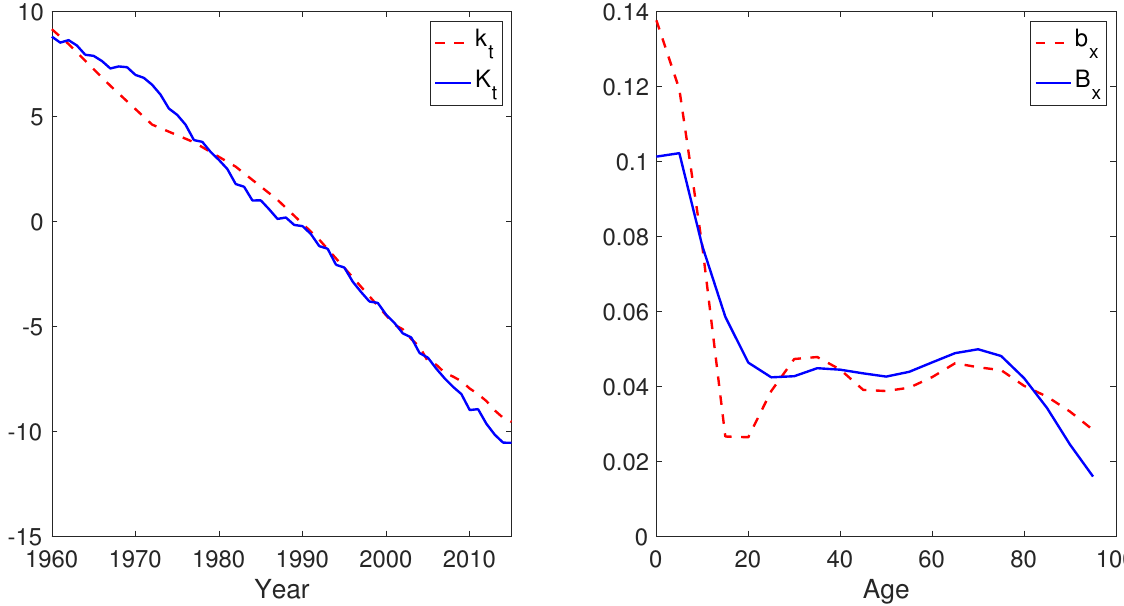
Figure 6. The historical period effects ( left panel ) and the age effects ( right panel ) of Brazil and the benchmark